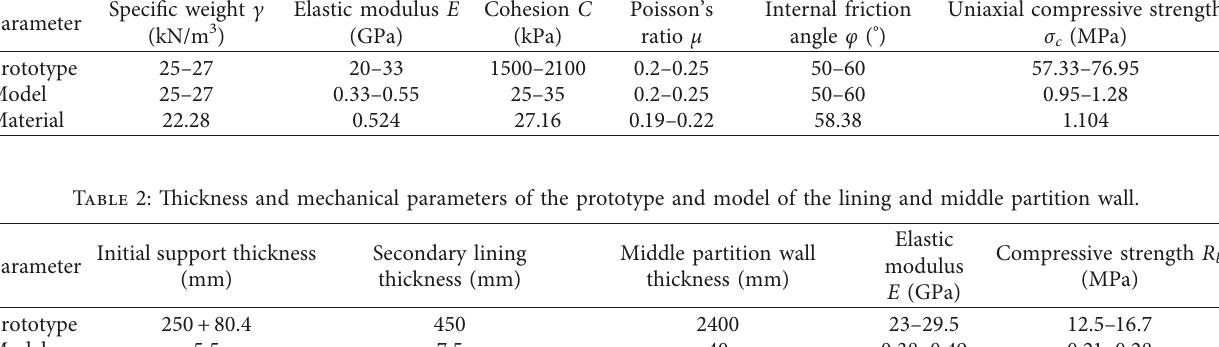
Figure 2: Cross section of the reconstructed and expanded tunnel unit (mm). Table 1: Mechanical indicators of similar materials of the surrounding rock.